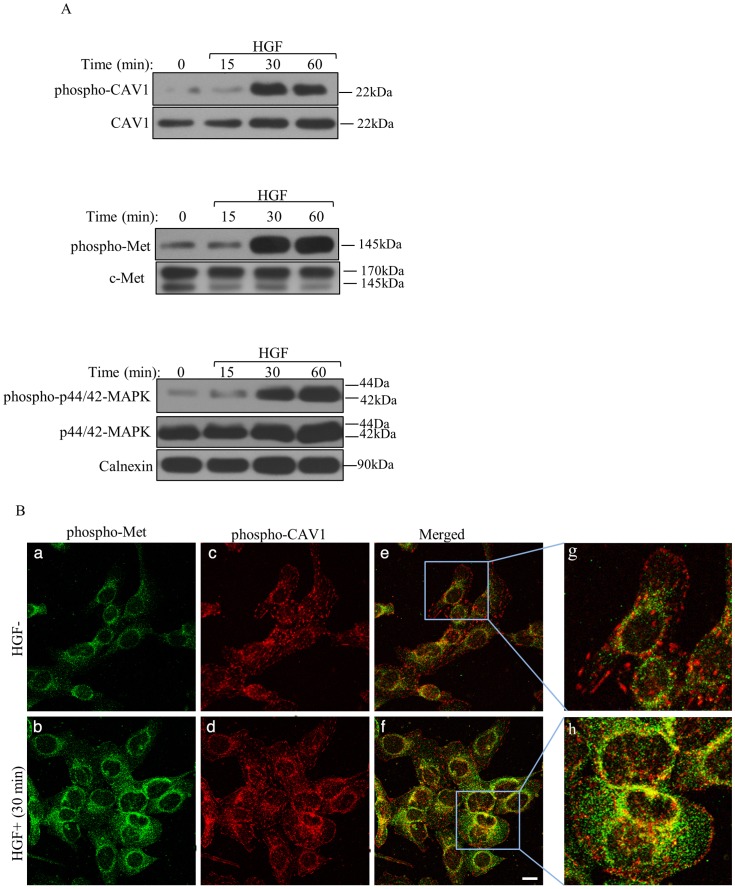
HGF mediated CAV1 activation.
A. WB showing the expression of the indicated proteins in SNU-449 cells, overnight starved and treated with or without HGF at different time points. Calnexin was used as a loading control. B. Representative images for co-localization of phospho-CAV1 with phospho-Met increased by HGF treatment. Induced or non-induced SNU-449 cells by HGF for 60 min were assessed for c-Met (Y1234/1235) (green) (a, b) and CAV1 (Y14) (red) (c, d) phosphorylation by immune fluorescent staining. Subsequent images were merged (e and f) and overlapping of red and green signals were shown in yellow, indicating the co-localization of two proteins. A higher magnification view of the SNU-449 cells was also shown (see boxed areas) (g, h). Bar: 200 µm.